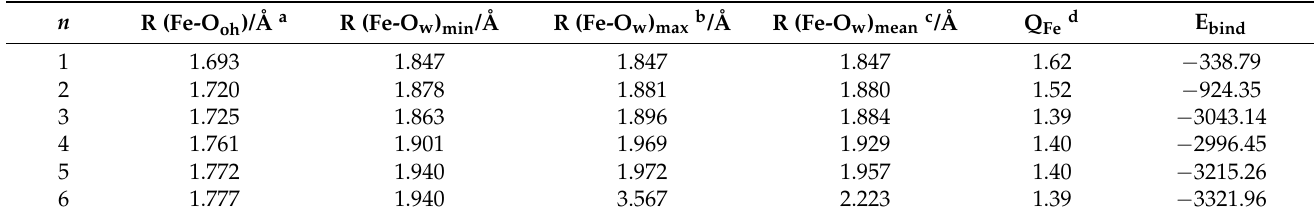
Table 1. Calculated structural parameters and energy of Fe(OH)(H 2 O) n 2+ ( n = 1–6).